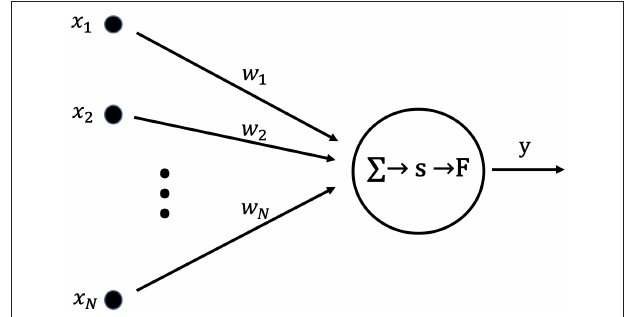
FIGURE 1 | Artificial neuron used as the fundamental building block for single layer neural networks. The internal state, s , is calculated as the product of the input vector, X , and the weight vector, W . Output y is obtained by applying the output function, F , to the internal state, s .